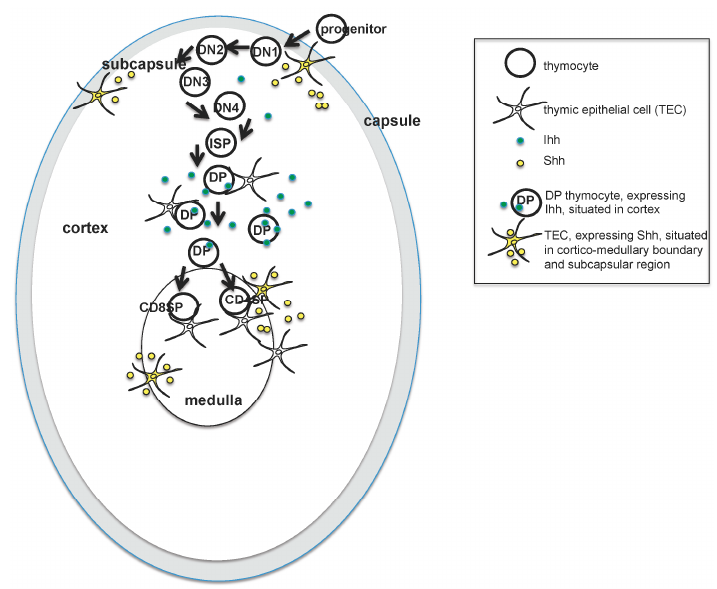
Figure 1. Hedgehog (Hh) expression in different microenvironments as thymocytes migrate through the embryonic thymus. The cartoon illustrates the stages of T cell development in the embryonic thymus, as developing thymocytes move through different thymus microenvironments and receive different amounts of Hh signal. Molecules of Indian hedgehog (Ihh, expressed by double positive (DP) thymocytes) are shown in green, and molecules of Sonic hedgehog (Shh, expressed by TEC in the sucbcapsular region and medulla) are shown in yellow. Progenitor cells first enter the embryonic thymus through the capsule on ~E12.5, and migrate towards the centre of the thymus as they differentiate. DP cells first appear on E16.5 and are located in the cortex. Mature single positive (SP) T cells and mature medullary TEC (mTEC) and cortical TEC (cTEC) populations are present by birth. During T cell development, thymocytes pass through a series of stages that have been defined by the expression of cell surface markers as they migrate through the thymus [6] (see Figure 1). In brief, the earliest thymocytes—termed CD4 − CD8 − double negative (DN)—rearrange the TCR β chain locus and express the pre-TCR in order to differentiate to the CD4+CD8+ double positive (DP) stage. They then rearrange the TCR α locus and must signal through the αβ TCR to differentiate to mature CD4+ single positive (SP) or CD8+ SP T cell. The DN population has been further subdivided by cell surface expression of CD44 and CD25. The earliest DN1 populations are CD44+CD25 − ; these then acquire CD25 expression (DN2), lose CD44 expression (DN3), and finally become CD44 − CD25 − (DN4) cells before differentiating to DP cell, often via a CD8+ immature single positive (ISP) intermediate.